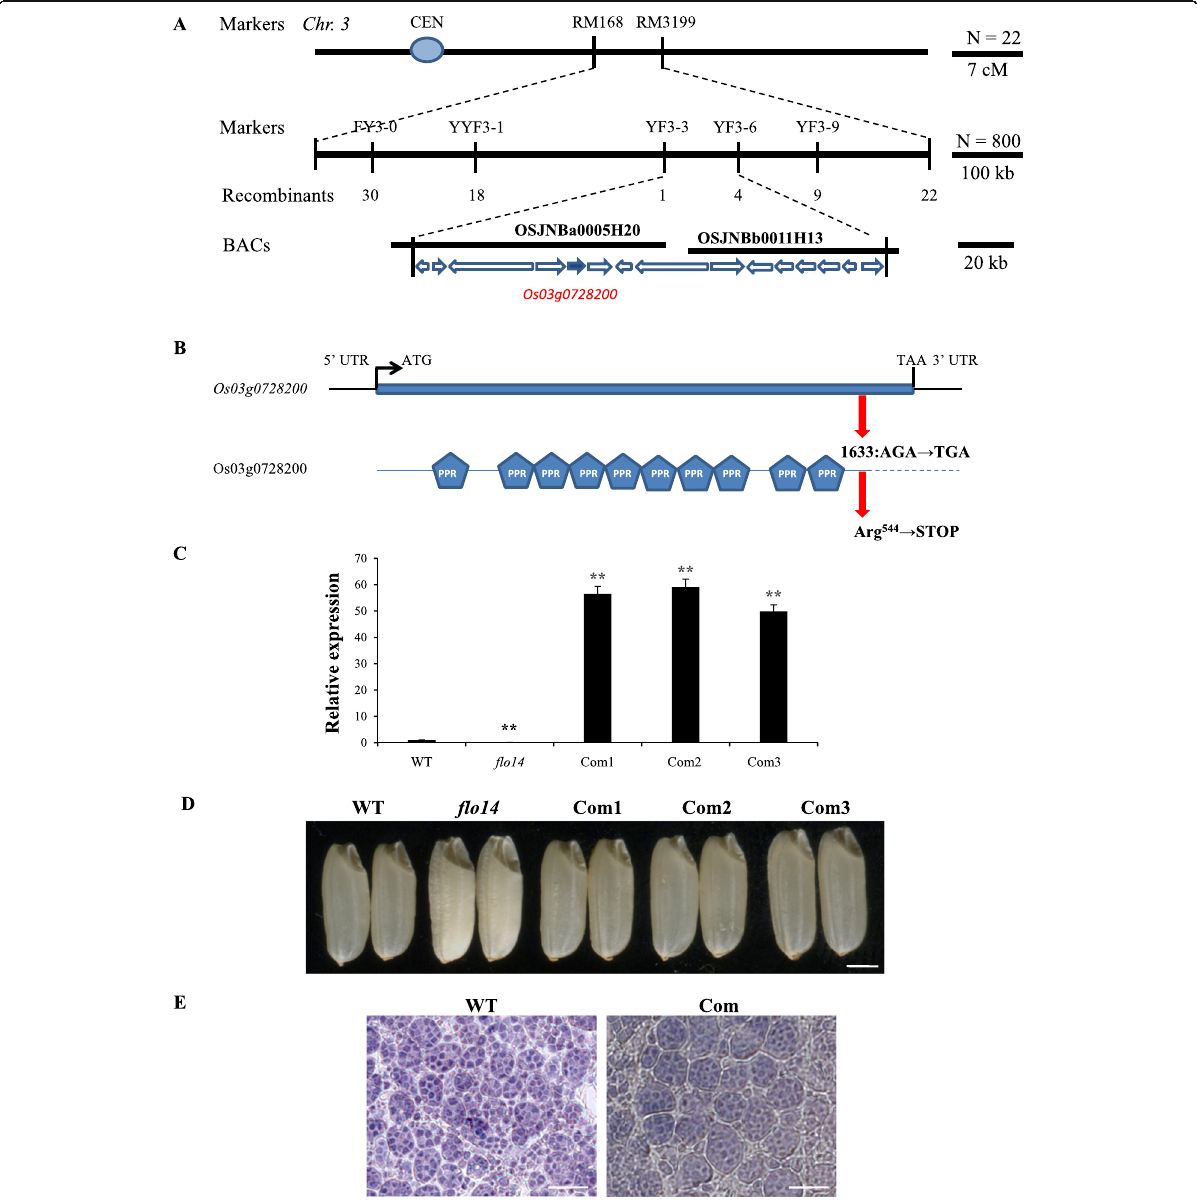
Fig. 3 Map-based cloning of the gene responsible for the OsNPPR3 phenotypes. a Fine mapping of the OsNPPR3 locus. The OsNPPR3 locus was mapped to a 165-Kb region by markers FY3 – 3 and FY3 – 6 on Chromosome 3 ( Chr.3 ), which contains 15 predicted genes. The number of recombinants is indicated below the map. The candidate gene is indicated by red arrow. b The PPR gene structure and its protein. The lines indicate 5 ′ -UTR and 3 ′ - UTR, respectively. The blue box means exon. ATG and TAA represent start codon and stop codon. The PPR protein contains 10 PPR motifs. A single nucleotide substituted in the coding region of mutant gene leads to a premature stop codon. c Real-time RT-PCR analysis of OsNPPR3 in developing endosperms at 12days after flowering (DAF) in the wild type (WT), flo14 mutant ( flo14 ) and three flo14 mutant lines expressing the wild-type OsNPPR3 gene (Com1, Com2 and Com3). The value of Actin I mRNA was used as an internal control for data normalization. d Complementation of the flo14 mutant restored normal seed appearance. e Semi-thin sections of wild type and the complementation of the flo14 mutant (Com) endosperm at 15 days after flowering. Values are means ± SD ( n =3). The asterisks indicate statistical significance compared with the flo14 mutant, as determined by a Student ’ s t – test (** P <0.01). Scale bars: 1mm in ( d ), 100 μ m in ( e abundance of both the rps2 and cyt c bands, but a slight de- the flo14 mutant and its wild type (Fig. 7a). Further, mito- crease in the ccmFc band compared to the wild-type profile chondrial electron transport chain (ETC) complex proteins (Fig. 7b), indicating that the accumulation of ETC compo- were isolated from developing endosperm and analyzed by nents is disturbed in the flo14 mutant. western blotting. The flo14 mutant displayed an increase